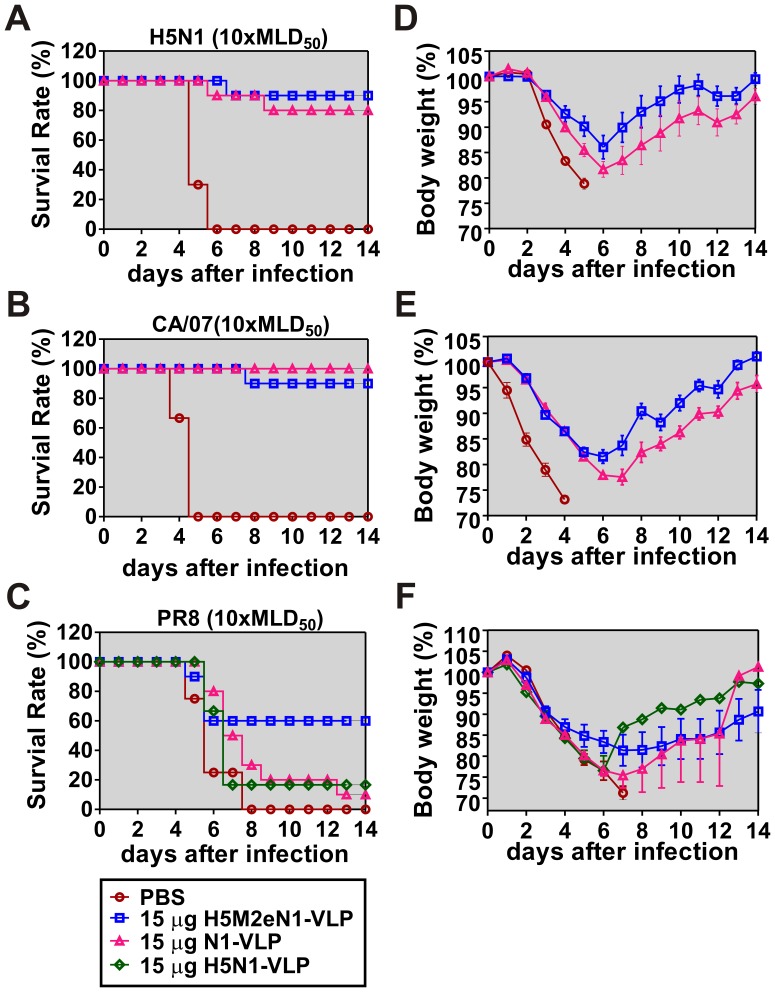
H5M2eN1-VLP vaccination broadens heterologous protections.Mice groups (n = 6–10) immunized with various VLP vaccines and infected with a lethal dose (10× MLD50) of reassortant RG-14 (H5N1) (A), CA/07 (B), or PR8 (C) influenza viruses. Body weight changes after infection with H5N1 (D), CA/07 (E), or PR8 (F) were recorded daily and plotted independently. The used dosage and individual VLP vaccines were as indicated.